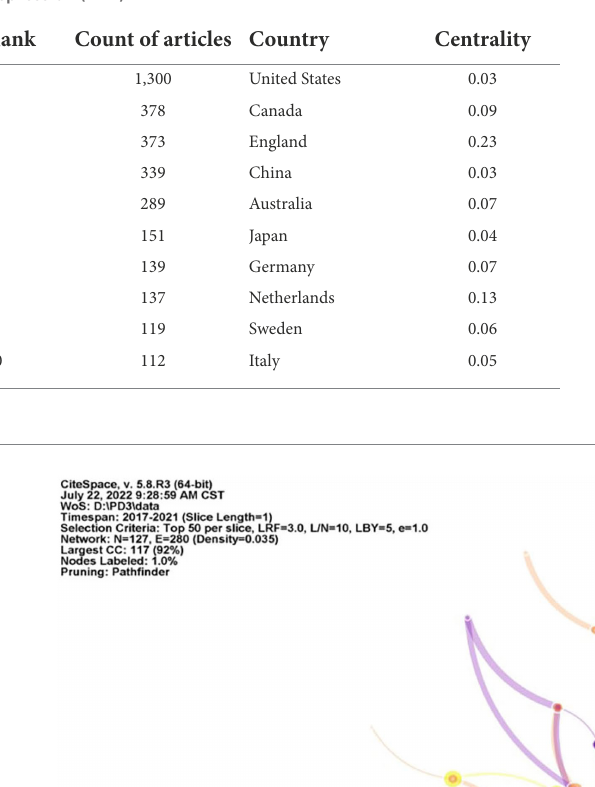
TABLE 1 Top 10 productive countries in the field of postpartum depression (PPD).